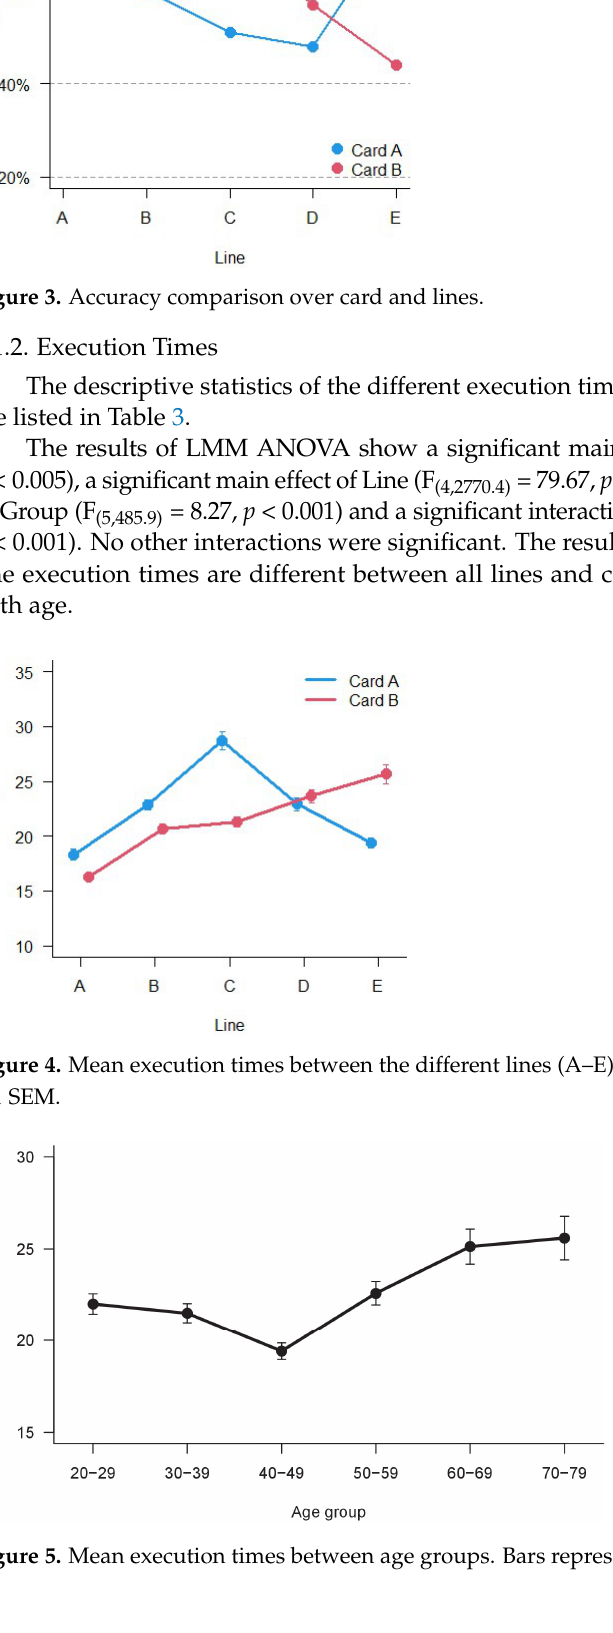
Figure 3. Accuracy comparison over card and lines.